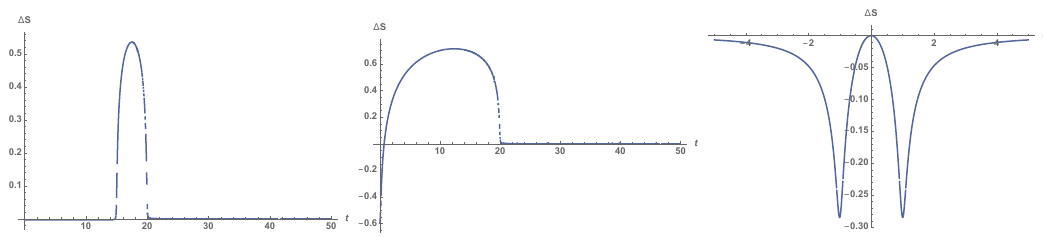
Figure 16 . The plots of the entanglement entropy growth S A (cid:0) S (0) local quench in the Dirac Fermion CFT. The left graph describes the time evolution when we take ( a; b ) = (15 ; 20). The middle one is the time evolution for ( a; b ) = (0 : 1 ; 20). The right one is the plot for various (cid:24) when we (cid:12)x l = 2 and t = 0.